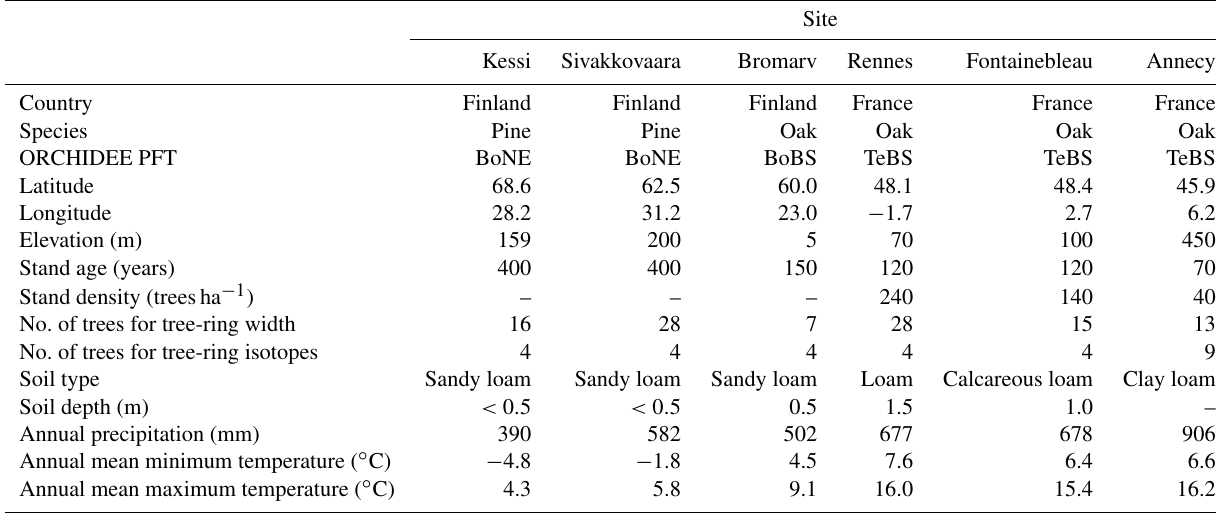
Table 1. Location and characteristics of the six tree-ring sites used for model evaluation. The ORCHIDEE plant functional types (PFTs) corresponding to the sites are boreal needleleaf evergreen (BoNE), boreal broadleaf summergreen (BoBS), and temperate broadleaf summer- green